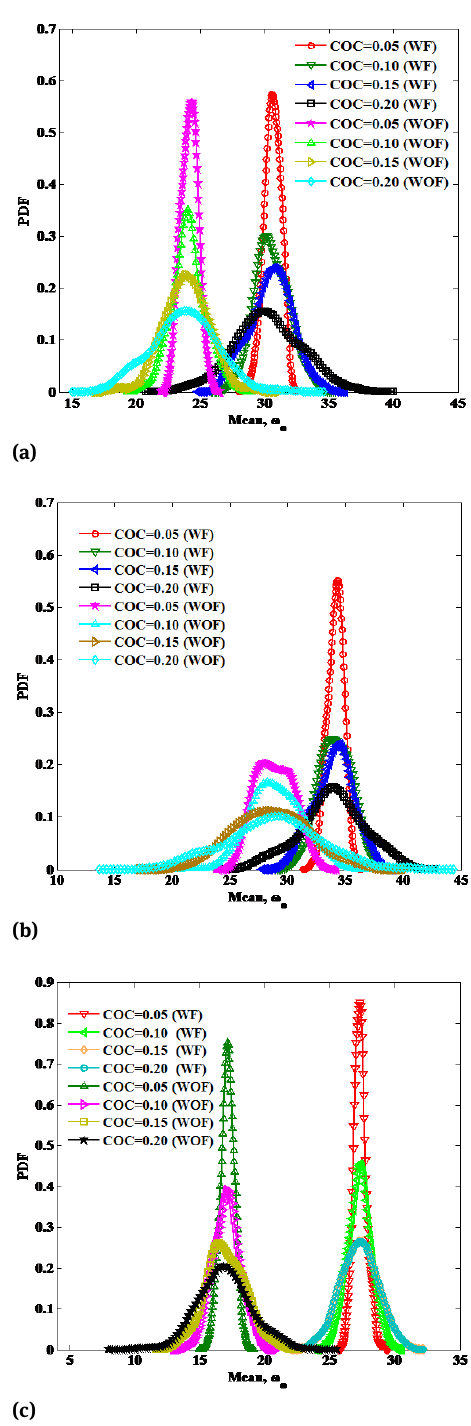
Figure 6: The effect of temperature variation on the PDF of nonlinear fundamental frequency of nonlinear elastically supported combined random variables { b i , ( i = 1 to 16) = (0.10) } with and without foundation for (a) UD and (b) FG-X and (c) FG- Λ distributed CNTRC beams at a / h = 25, W max/ h = 1, V * cn = 0.28 , COC = 0.10, N = 10 4 .